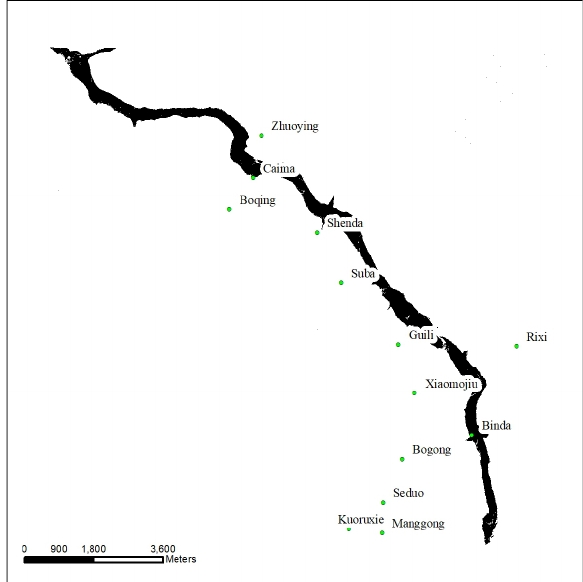
Figure 6. Sentinel-1A image on Nov 4, 2018